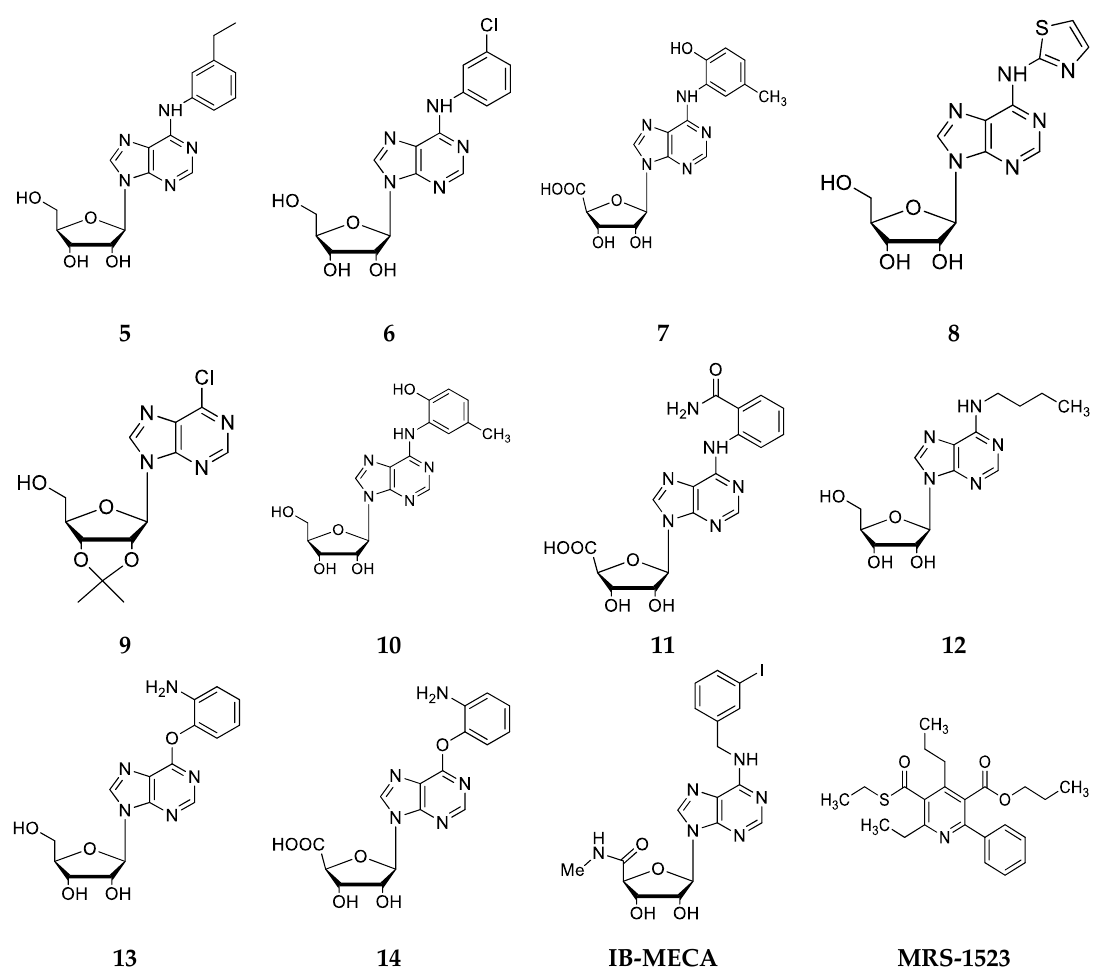
Figure 2. Chemical structures of selected compounds derived from in silico analyses.